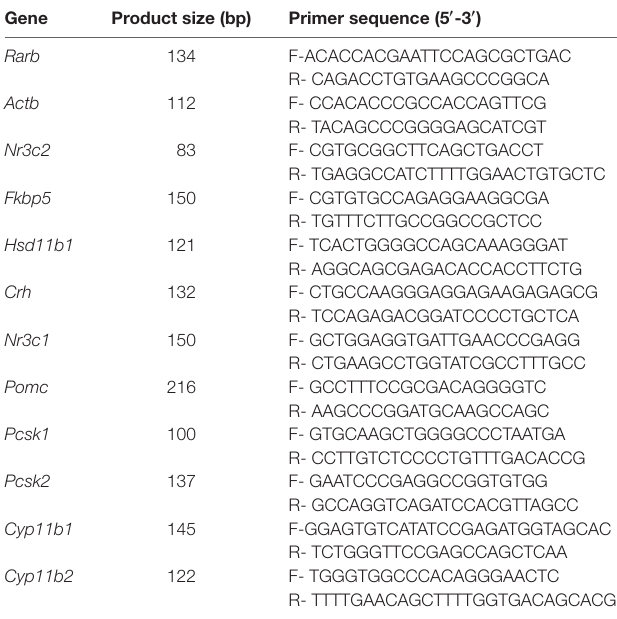
TABLE 1 | Genes and primer sequences for qPCR.